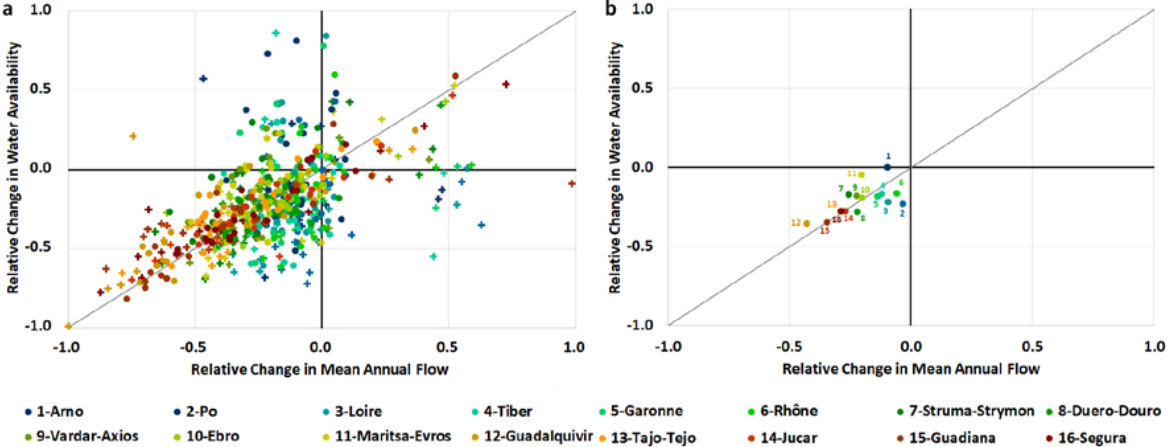
Figure 7. Comparison of the estimated changes in Mean Annual Flow ( ∆ F) and the estimated changes in Potential Water Availability ( ∆ PWA) for the 35 available projections in the 16 basins under study. ( a ) ∆ F vs. ∆ PWA, all projections; ( b ) ∆ F vs. ∆ PWA, mean values.